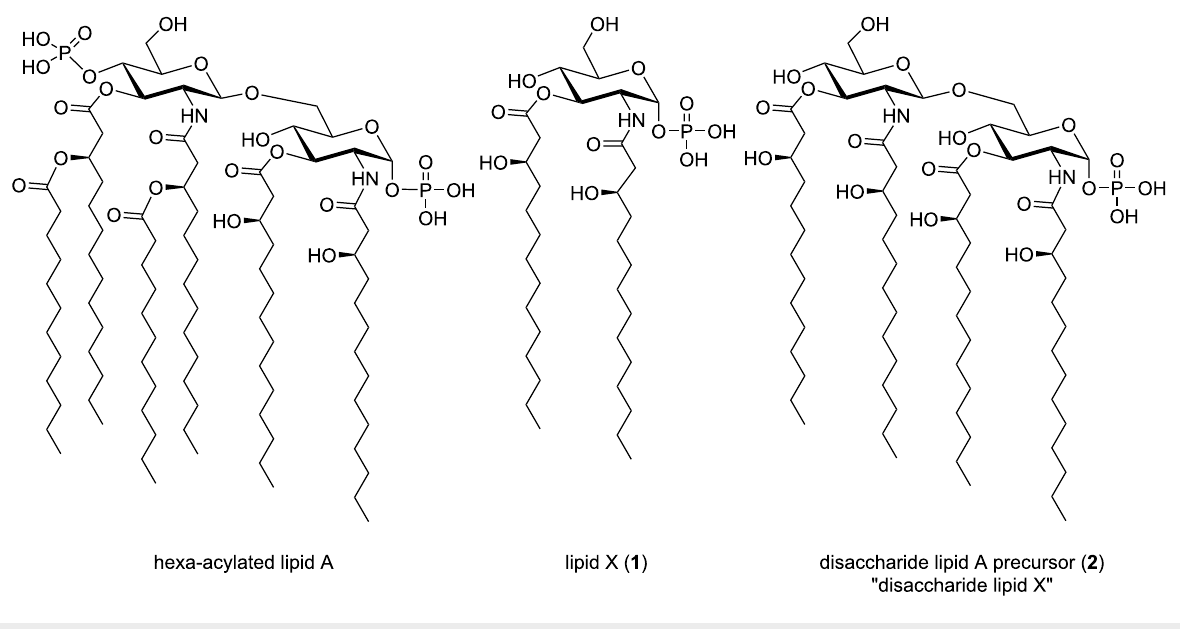
Figure 1: Chemical structures of hexa-acylated Escherichia coli lipid A, monophosphorylated lipid X (the reducing monosaccharide lipid A precursor), and disaccharide lipid A precursor (“disaccharide lipid